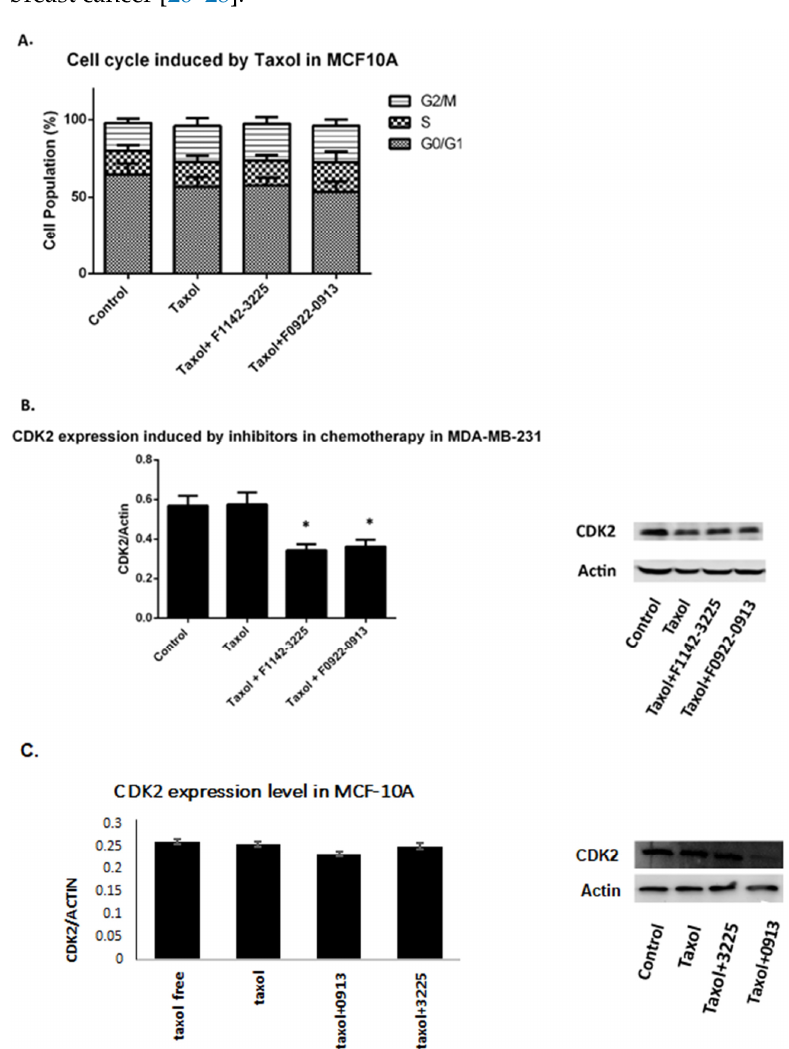
Figure 7. The cell cycle distribution of MCF10A cells and CDK2 protein expression in response to combination treatment in TNBC cell lines. ( A ) Cell cycle distribution in response to combination treatment of taxol with either F1142-3225 or F0922-0913 in MCF10A cells. Data are presented as % of living cells (G0/G1, S, and G2/M cells = 100%). Each number represents the mean of experiments, carried out in triplicate (mean ± SD). Statistical significance was determined by one-way ANOVA. ( B ) CDK2 protein expression, following combination treatment of taxol with either F1142-3225 or F0922-0913 for 48 h, was determined by western blot in MDA-MB-231 cells and MDA-MB-468 cells. ( C ) CDK2 protein expression in the control cell line MCF-10A, following combination treatment of taxol with either F1142-3225 or F0922-0913 for 48 h, was determined by western blot. Data are re-